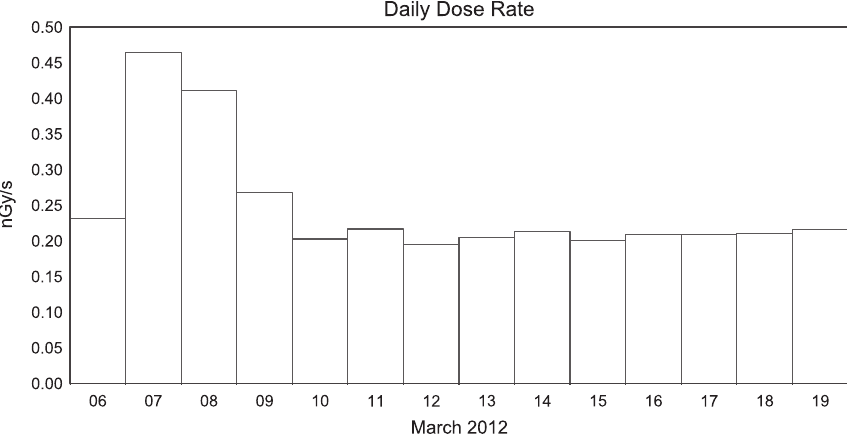
Fig. 10. Daily dose rate recorded by ALTEA SDU1 between March 6th and March